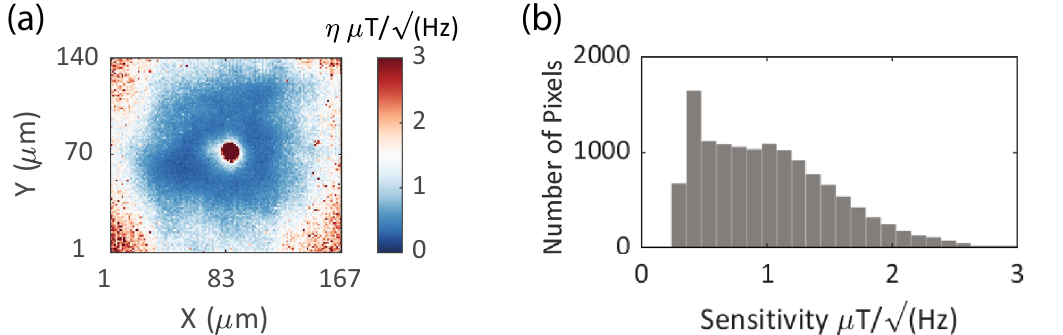
Figure 3. Per-pixel sensitivity: ( a ) measured 2D map of sensitivity of all responsive pixels. Due to the Gaussian nature of the beam spot, the SNR drops in the outer periphery of the field-of-view (FOV). Pixels with sensitivity better than 3 µ T / √ Hz have been included. Some pixels at the center of FOV are non-responsive due to a damage in the objective. ( b ) Histogram of sensitivity of all responding pixels, with median sensitivity of 731 nT / √ Hz